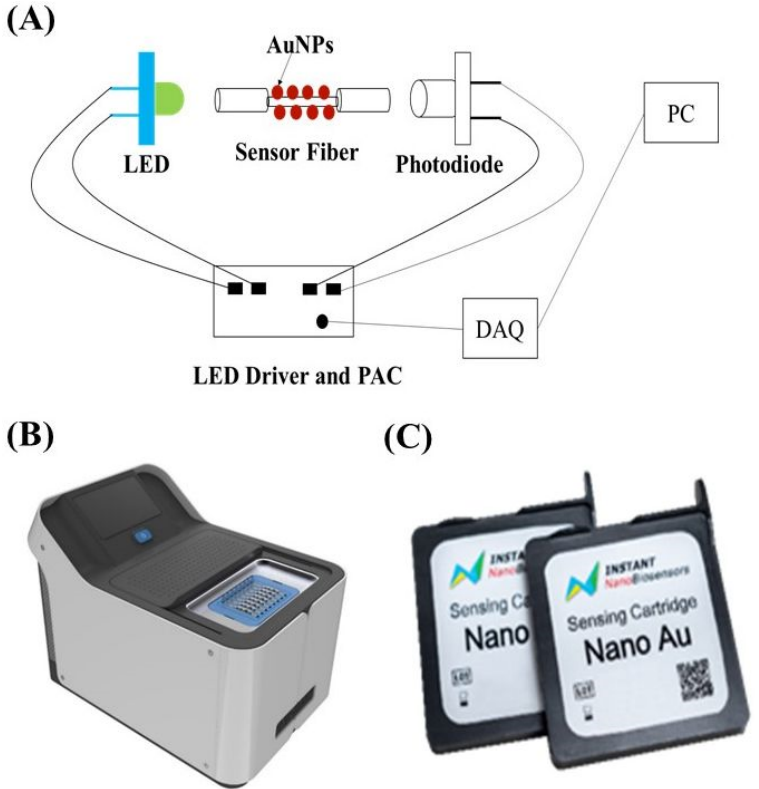
Figure 1. ( A ) Schematic representation of the modules used in the light-sensing Biomarker Analyzer INB-D200 biosensing system; ( B ) photograph of the commercialized product light-sensing Biomarker Analyzer (INB-D200) developed by Instant NanoBiosensors Co., Ltd.; ( C ) photograph of the auto-flowing sensor chips developed by Instant NanoBiosensors Co., Ltd. for sample analysis.